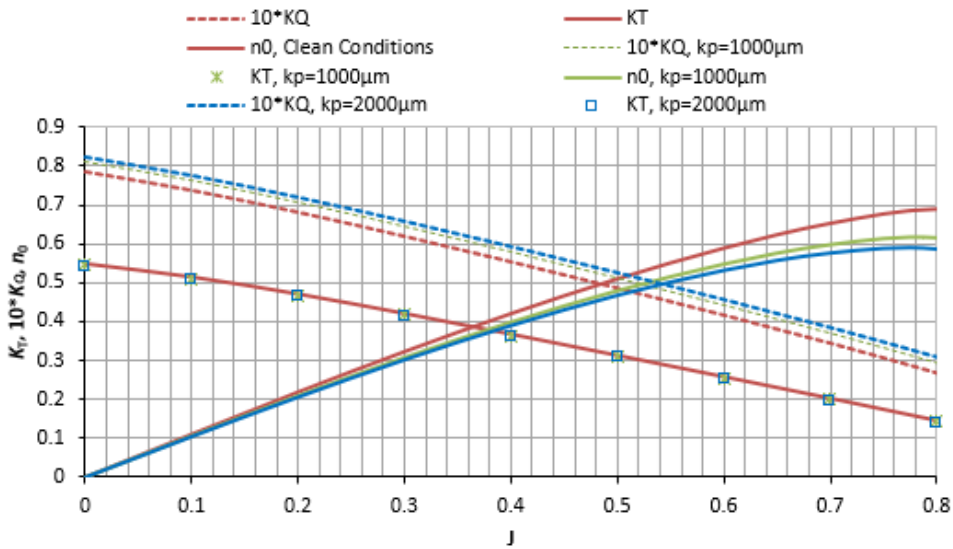
Figure 3. Propeller’s fouling effect on propeller’s open water characteristic curves.